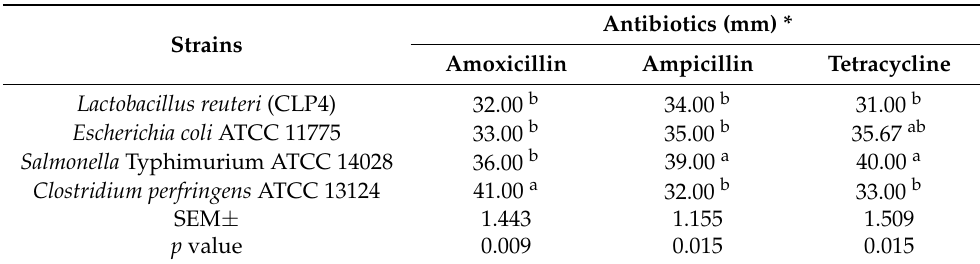
Table 4. Evaluation of the antibiotic sensitivity of the Lactobacillus spp. isolates from the cecal content of Creole roosters ( n =